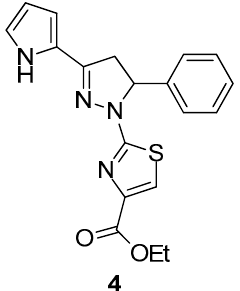
Figure 5. Chemical structure of 1-(4-ethylcarboxylate-thiazol-2-yl)-3,5-di(hetero)aryl-2-pyrazoline derivative 4 .